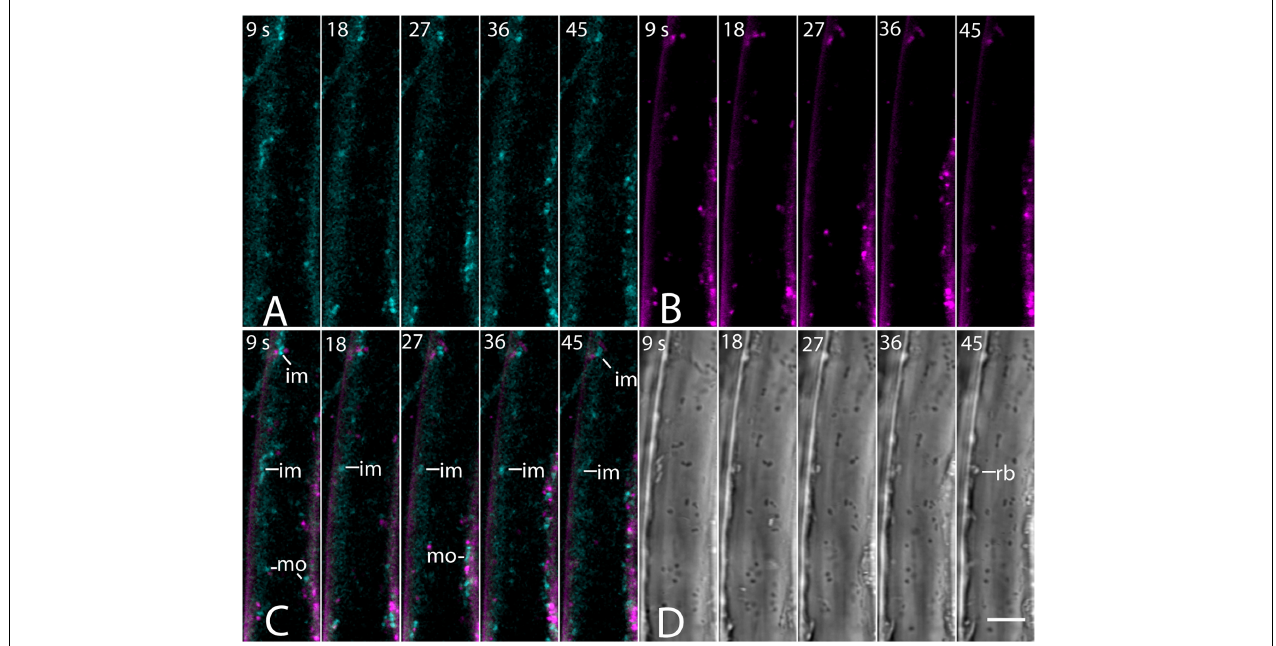
FIGURE 8 | Labeling of elongating root cells with BCh (cyan, A ) and FM4-64 (magenta, B ) after 30 min of co-incubation. (A) Fluorescent structures associated with the PM and in the cytoplasm. (B) Red fluorescent, mostly motile, endosomes labeled with FM 4-64 after 30 min. (C) Merged image of (A and B) – punctate structures do not colocalize. BCh labels immobile (im) and motile (mo) structures. (D) Bright-field image. rb, refractile body. Images taken at 9 s intervals. Scale bar = 5 µ m.